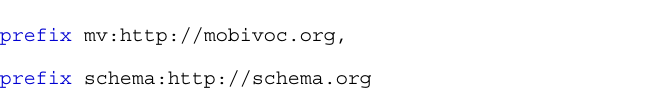
Scheme 2. Example of PREFIX clause. Figure 8. PREFIX clause production rule visualisation. Figure 8. PREFIX clause production rule visualisation.